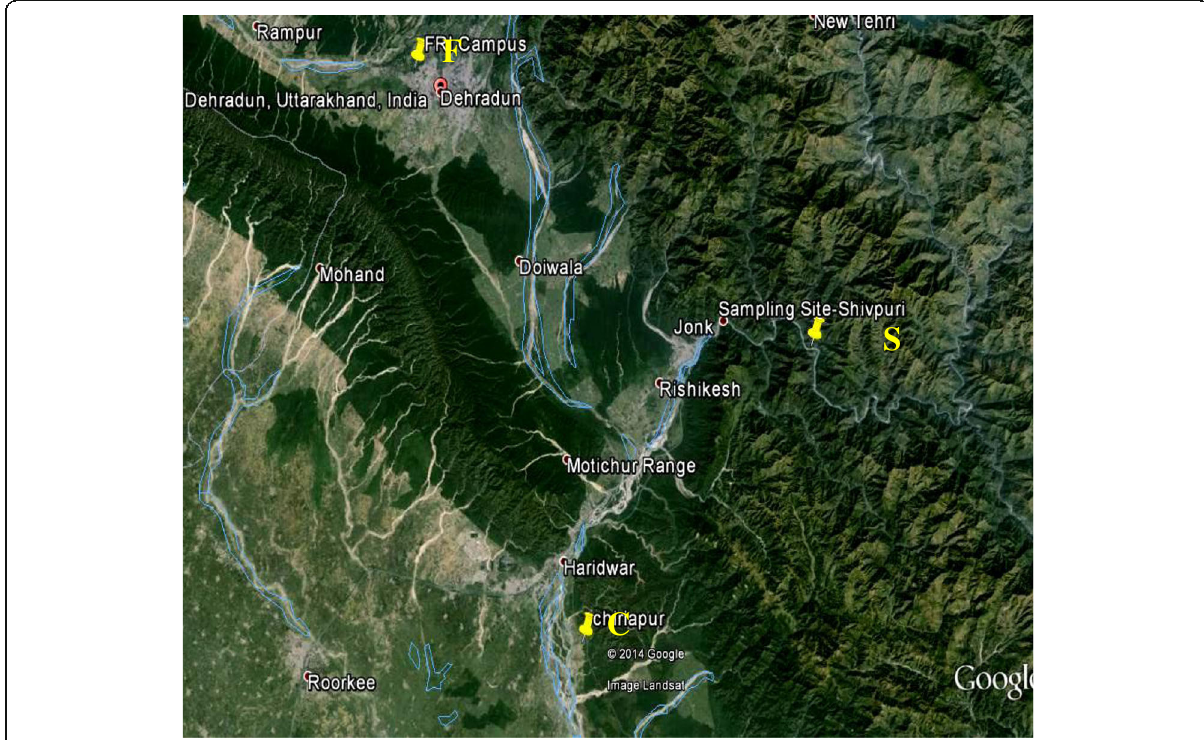
Fig. 1 Geographical isolation of sampling sites (F: FRI campus (Lat. 30° 20 ′– 08.86 ′ N; Long. 78° 00 ′– 150.81 ′ E), S: Shivpuri (Lat. 30° 06 ′– 53.93 ′ N; Long. 78° 25 ′– 49.72 ′ E) and C: Chiriapur (Lat. 29° 52 ′– 53.25 ′ N; Long. 78° 11 ′– 03.37 ′ E) showing physical barriers such as mountain range as well as rivers and rivulets. ( Source : Google